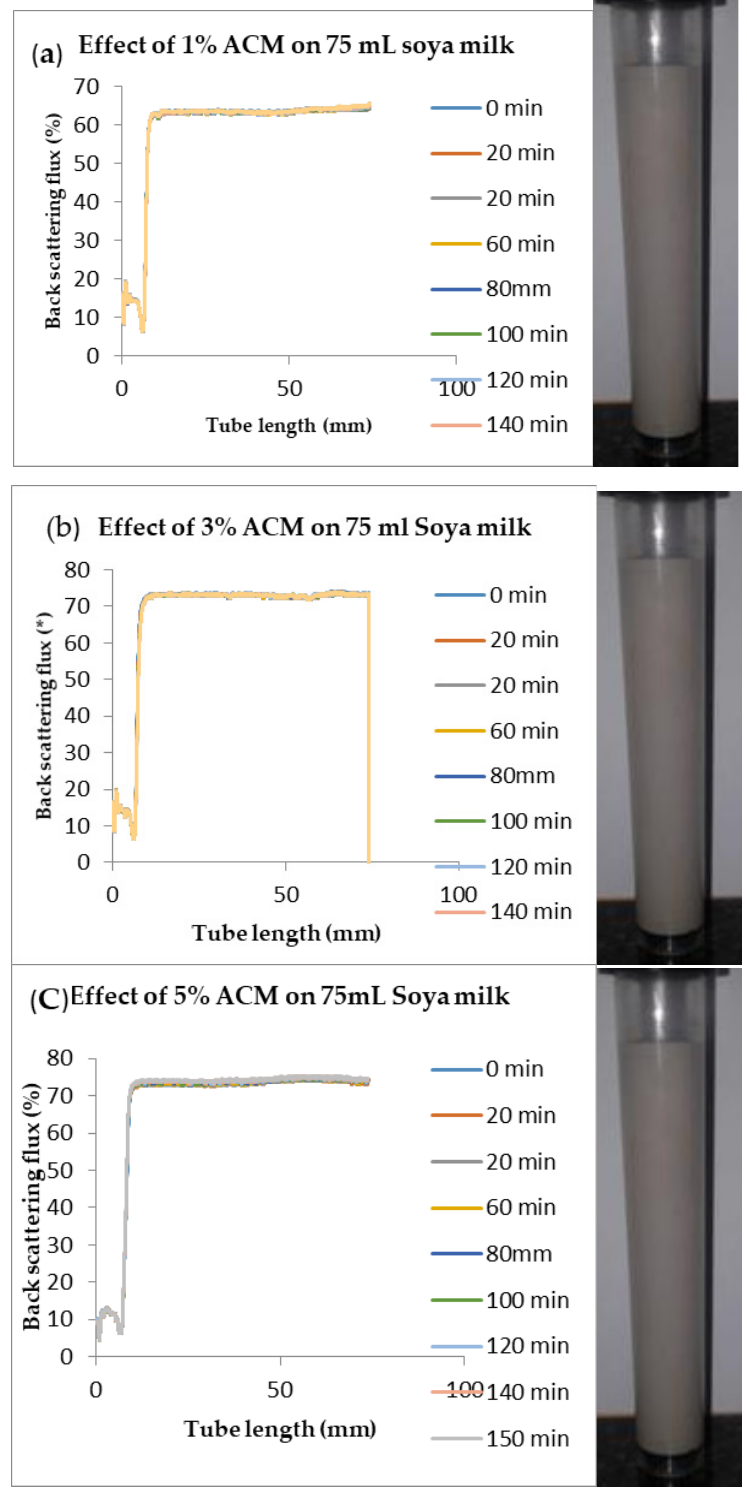
Figure 6. Changes in stability of ACM-stabilized 75 mL ( w / w ) soya milk emulsions ( a ) 1 g w / w ; ( b ) 3 g w / w ; ( c ) 5 g w / w African catfish mucus.